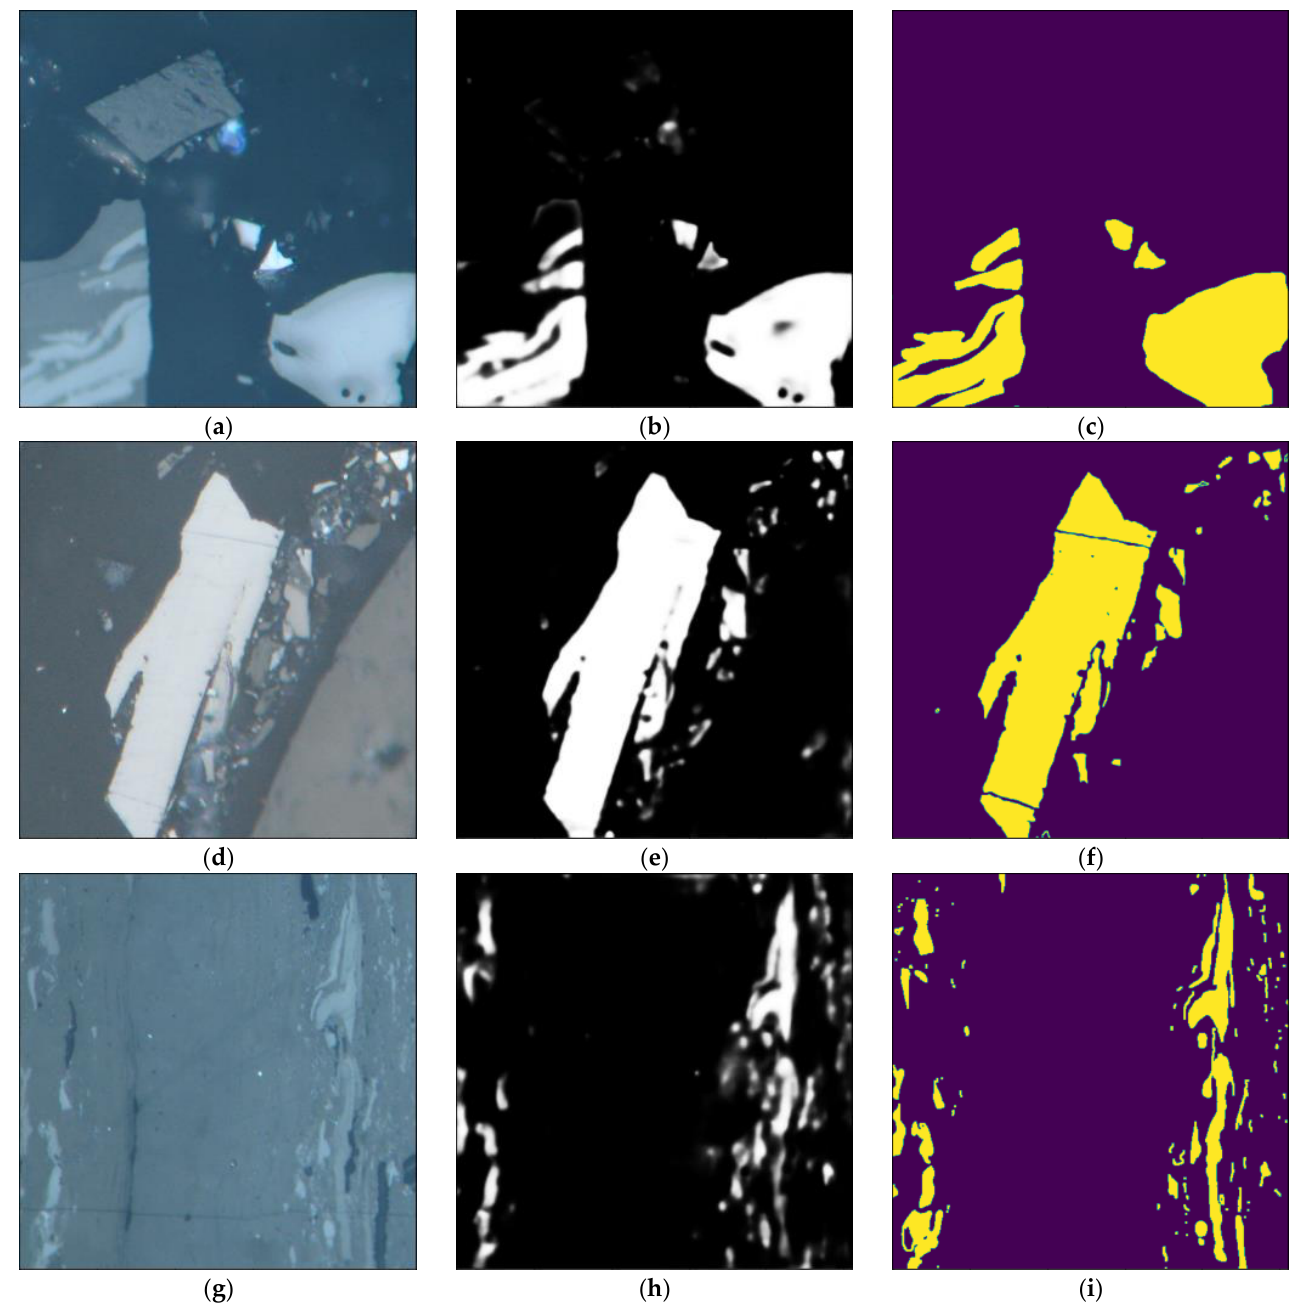
Figure 6. The results of inertinite segmentation. ( a , d , g ) Input images; ( b , e , h ) segmentation results; ( c , f , i ) ground truth.